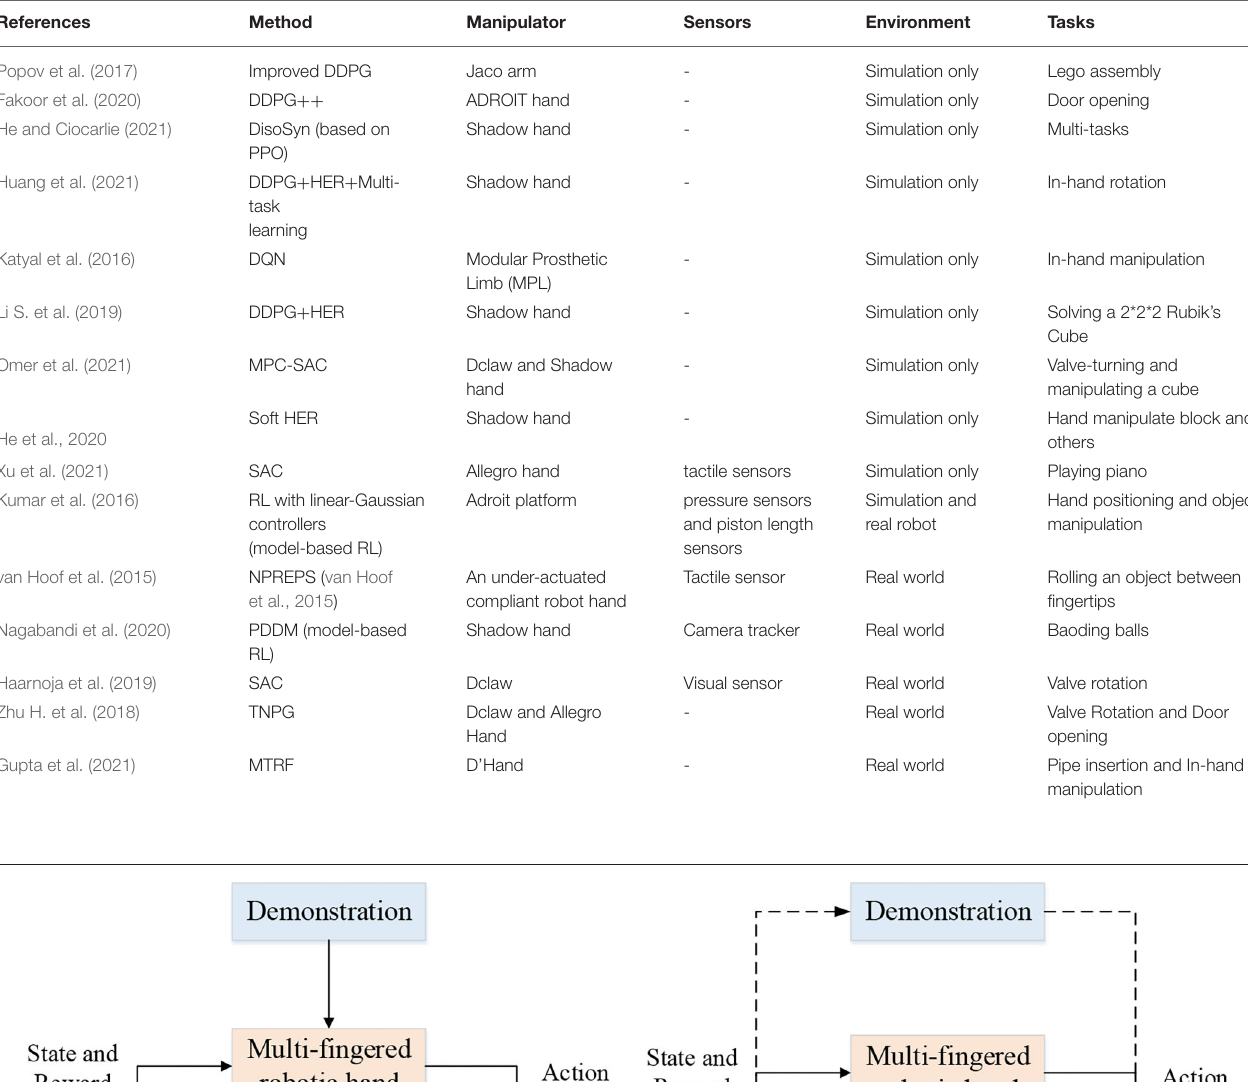
TABLE 5 | Overview of the dexterous manipulation solved by RL from scratch.